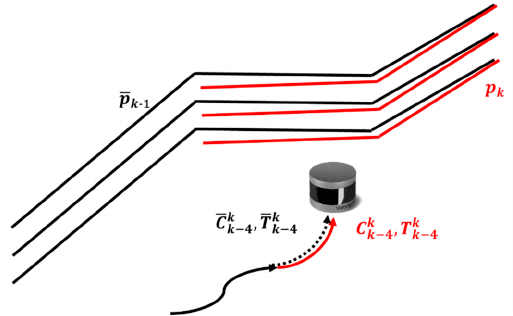
Figure 5. Demonstration of the LiDAR mapping process.